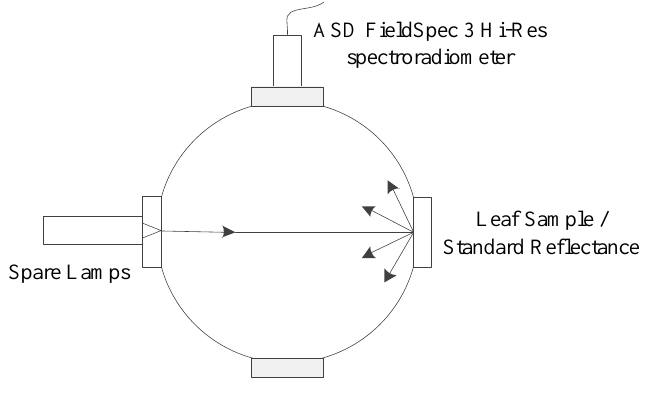
Figure 1. Sketch of the ASD integrating sphere